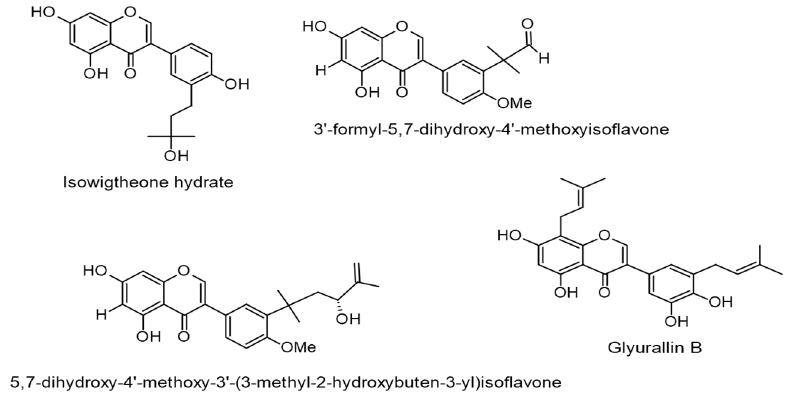
Figure 4. Chemical structures of isoflavones with therapeutic effects against EBV-associated cancers.